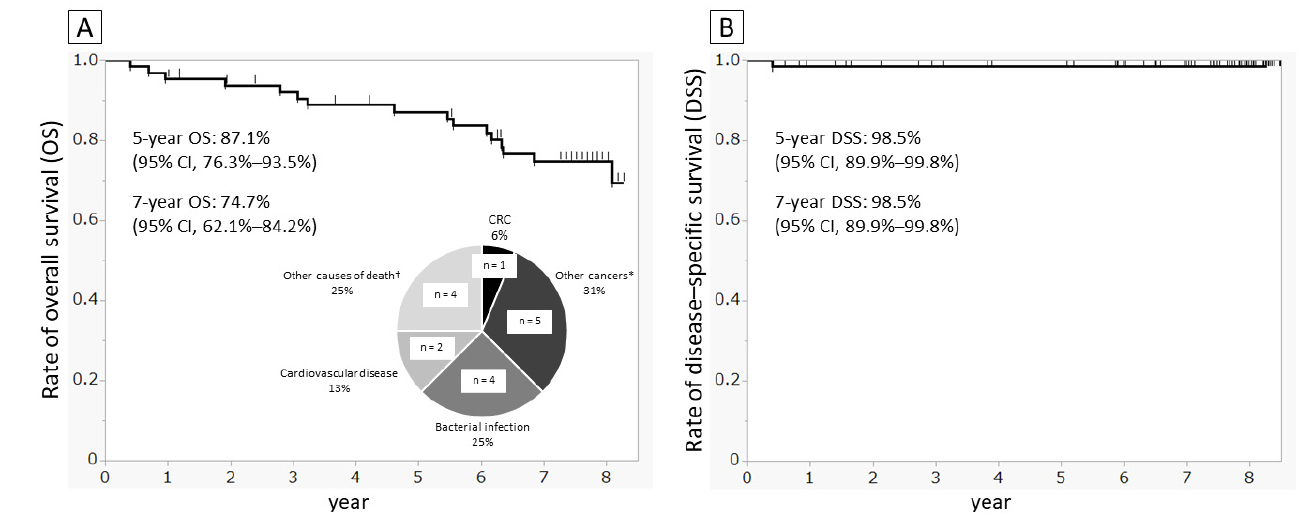
Figure 3. Survival curves and causes of death. Curves drawn using the Kaplan–Meier method. ( A ) Overall survival and causes of death and ( B ) disease-specific survival for CRC in 66 fecal occult blood-positive patients among FOBT submission until February 2021. * Lung cancer in two patients and one duodenal papillary carcinoma, one prostate cancer, and one renal carcinoma. † One patient with heart failure, one with failure to thrive, one with drowning, and one with sudden death during hospitalization.